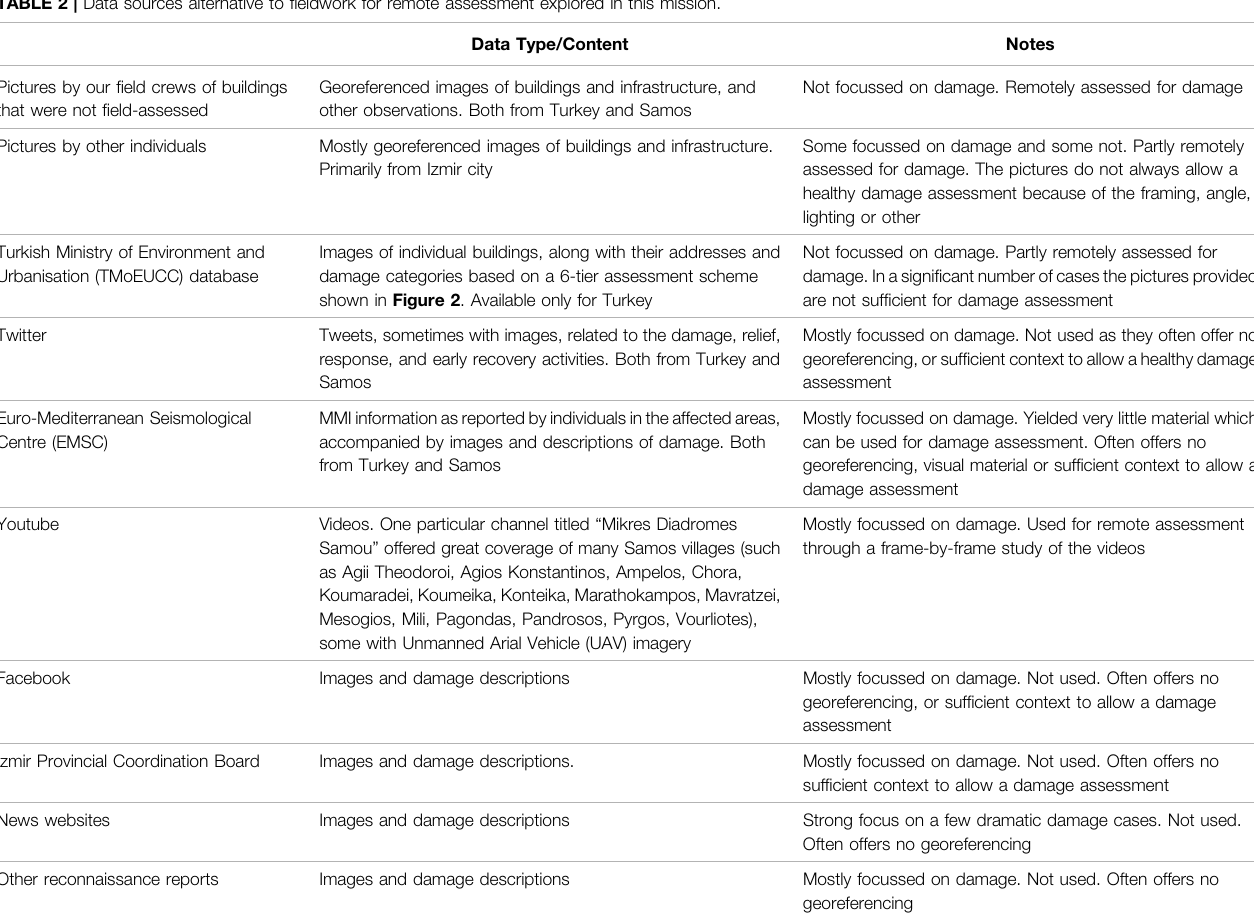
TABLE 2 | Data sources alternative to fi eldwork for remote assessment explored in this